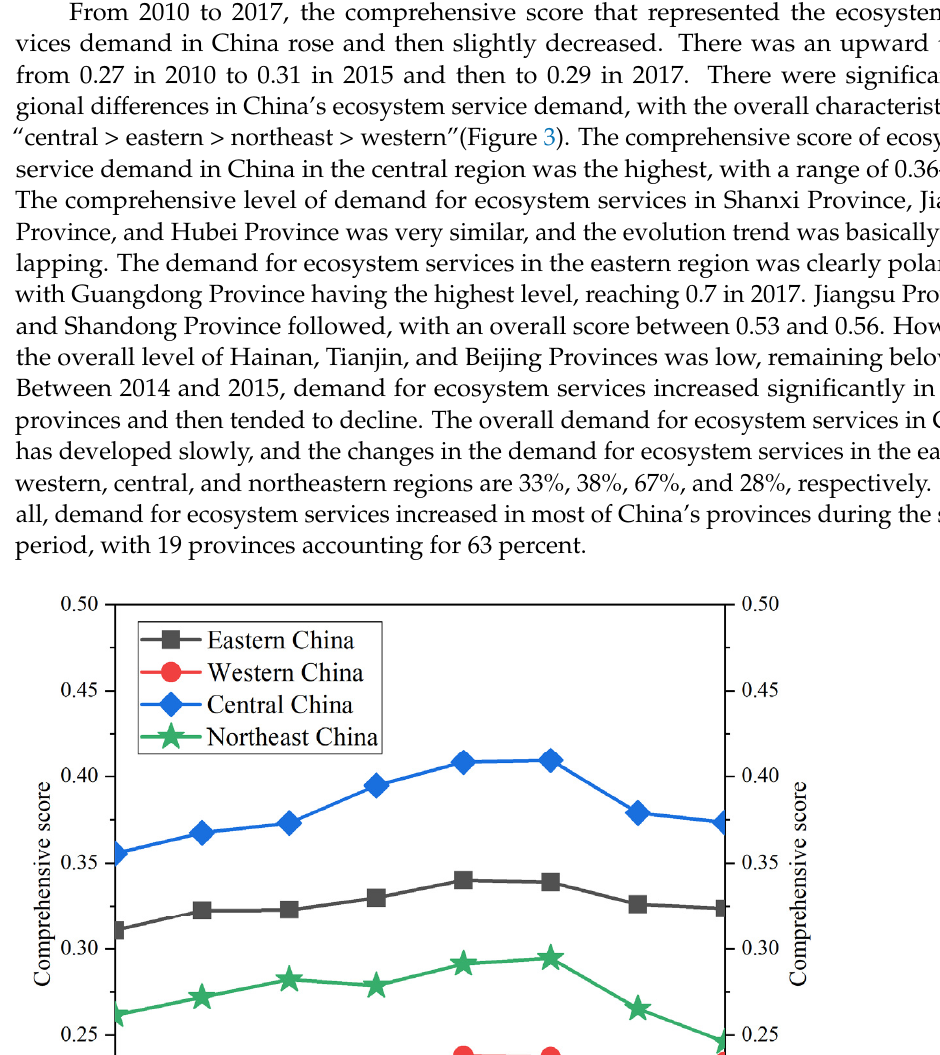
Figure 4. Spatial distribution of ecosystem service demand in China from 2010 to 2017. 4.3. The Coupling Coordination Relationship between Green Finance and Ecosystem Service De- mand 4.3.1. Traditional Coupling Coordination Model To verify whether the values of α and β have significant effects on the evaluation results of coupling coordination degree, five different combination scenarios were set ( α = 0.2, β = 0.8; α = 0.4, β = 0.6; α = 0.5, β = 0.5; α = 0.6, β = 0.4; α = 0.8, β = 0.2), and the corresponding evaluation results of the coupling coordination degree were compared and